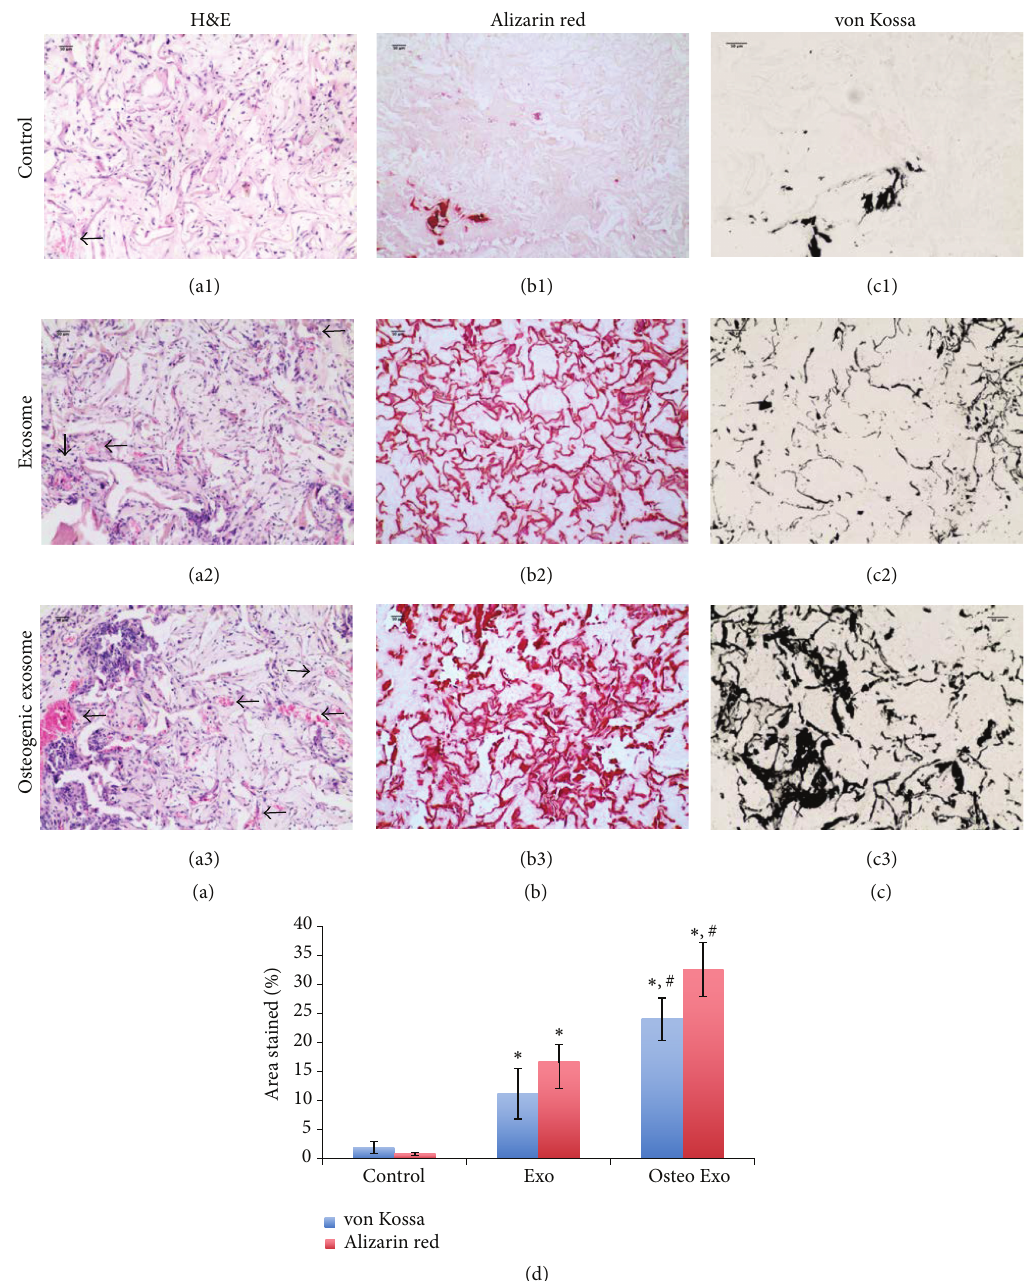
Figure 4: Histology of scaffold explant sections from in vivo implantation: (a1, a2, and a3) Representative H&E stained images of sections from control, regular exosome treated, and osteogenic exosome treated scaffolds containing HMSCs, respectively. Arrows point to blood vessels. Note the increase in the presence of blood vessels in the images from exosome treated scaffolds. (b1, b2, and b3) Representative alizarin red stained images of sections from control, regular exosome treated, and osteogenic exosome treated scaffolds containing HMSCs, respectively. Note the robust increase in calcium presence in exosome treated sample sections. (c1, c2, and c3) Representative von Kossa stained images of sections from control, regular exosome treated, and osteogenic exosome treated scaffolds containing HMSCs, respectively. Note the increase in presence of calcium phosphate in the exosome treated sections. Also, note the increase in vascularization and calcium phosphate presence in sections from osteogenic exosome treated samples compared to regular exosome treated samples. (d) is a graphical representation of histological data from triplicate experiments showing mean percentage area stained with von Kossa (blue bars) and alizarin red (red bars) stains. Error bars represent SD. ∗ represents statistical significance with respect to control ( 𝑃 < 0.01 ). # represents statistical significance between exosome and osteogenic exosome treated groups ( 𝑃 < 0.05